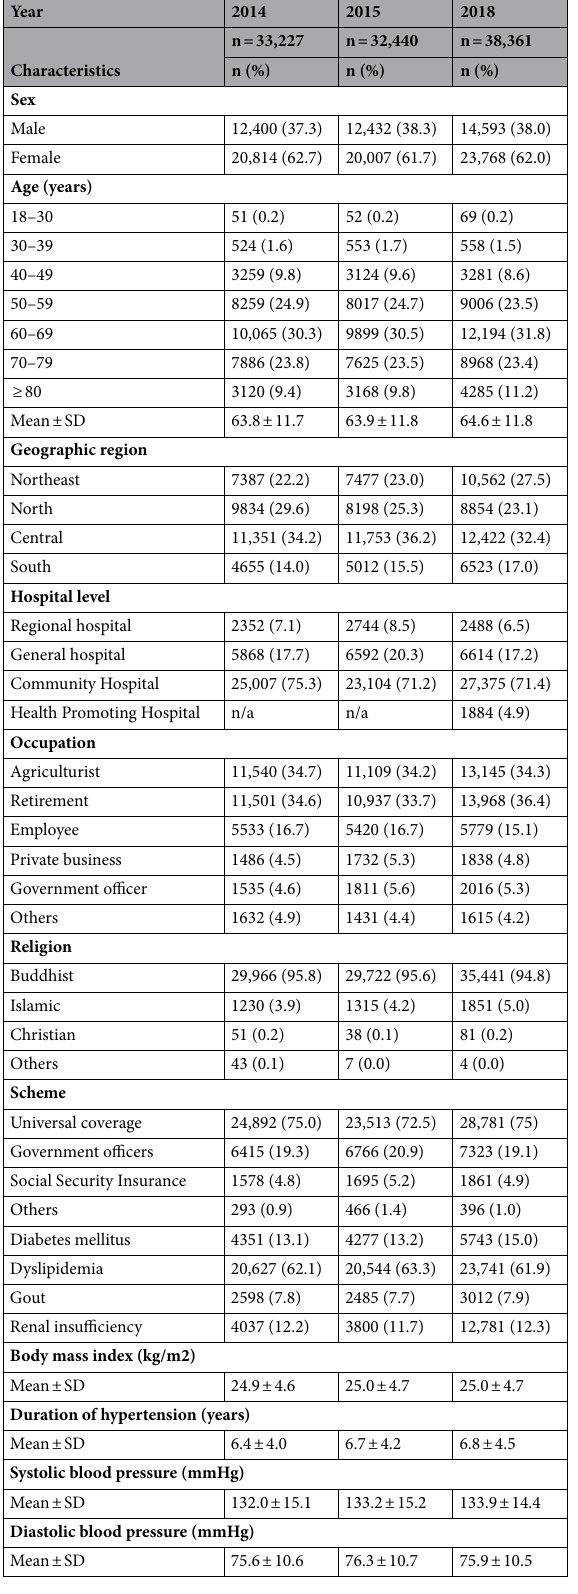
Table 1. Demographic characteristics of participants (n = 104,028). n/a = not